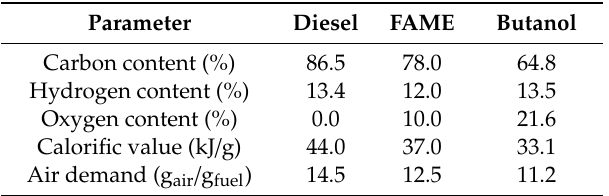
Table 2. Selected properties of the fuels applied. FAME—fatty acid methyl esters.